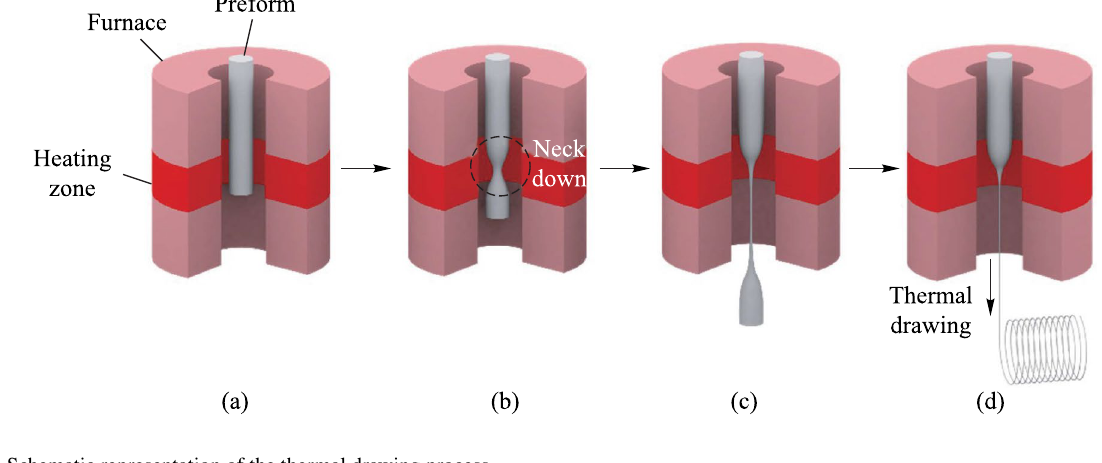
Fig. 2 Schematic representation of the thermal drawing process